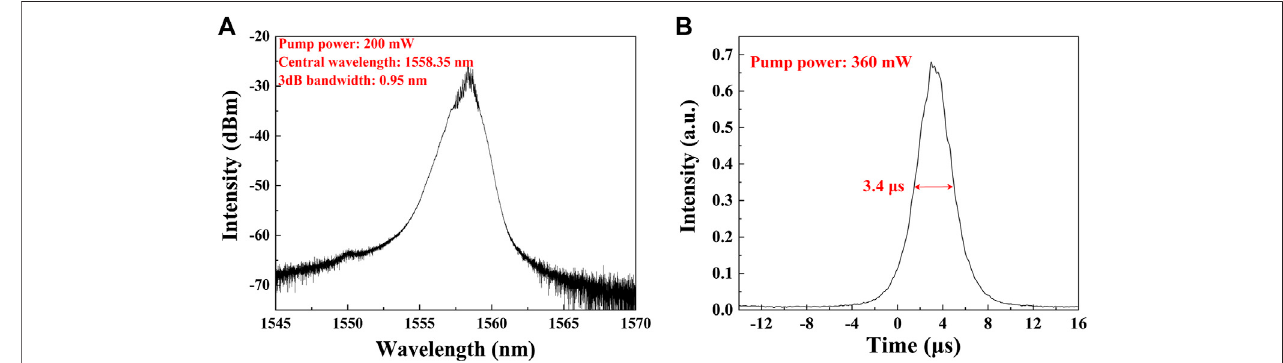
FIGURE 6 | (A) The optical spectrum; (B) A single-pulse pro fi le of the Q-switched pulses.